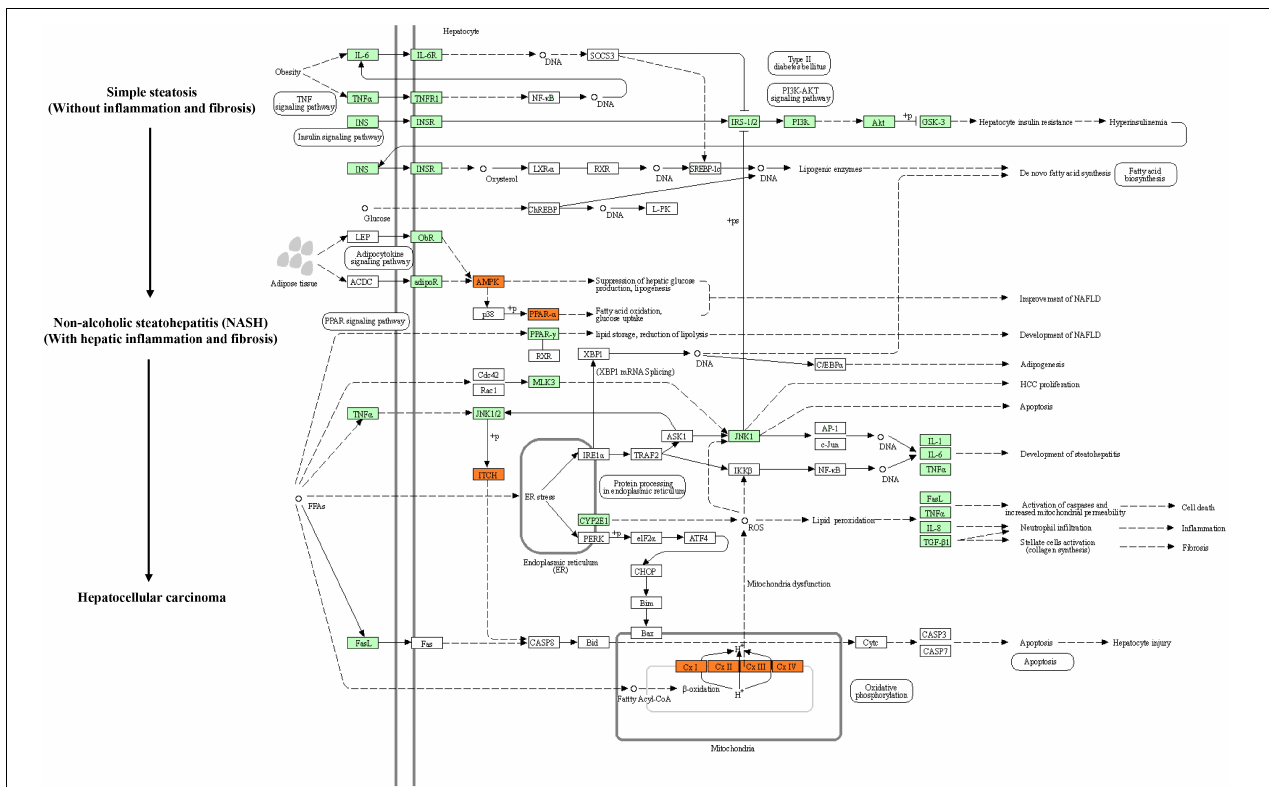
FIGURE 5 | PPC improves NAFLD by regulating hepatic metabolism and inflammation in HFD mice. The flow chart shows the Non-alcoholic fatty liver disease pathway (mmu04932) in KEGG. Genes identified as DEGs between HFD and HFD + PPC in our study are marked in red frames (upregulated) and green frames (downregulated), while others are marked in blank